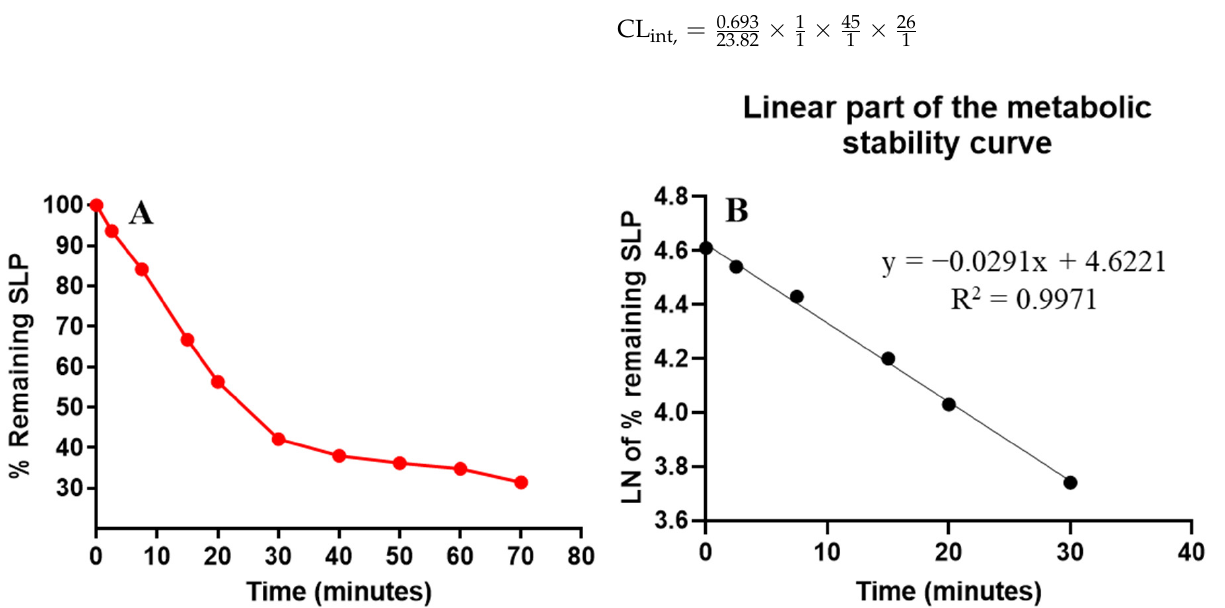
Figure 4. The curve of SLP metabolic stability in HLMs ( A ) and the linear LN calibration curve showing the linear regression equation with coefficient of variation ( B ).